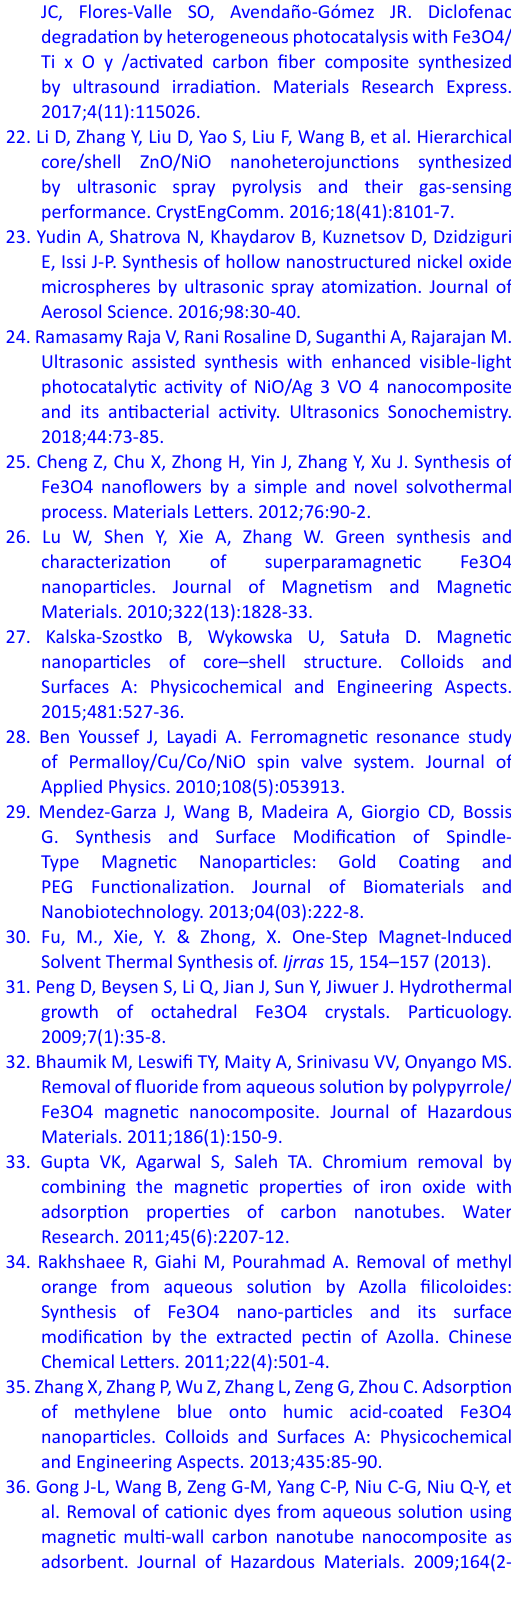
299 J Nanostruct 9(2): 287-300,